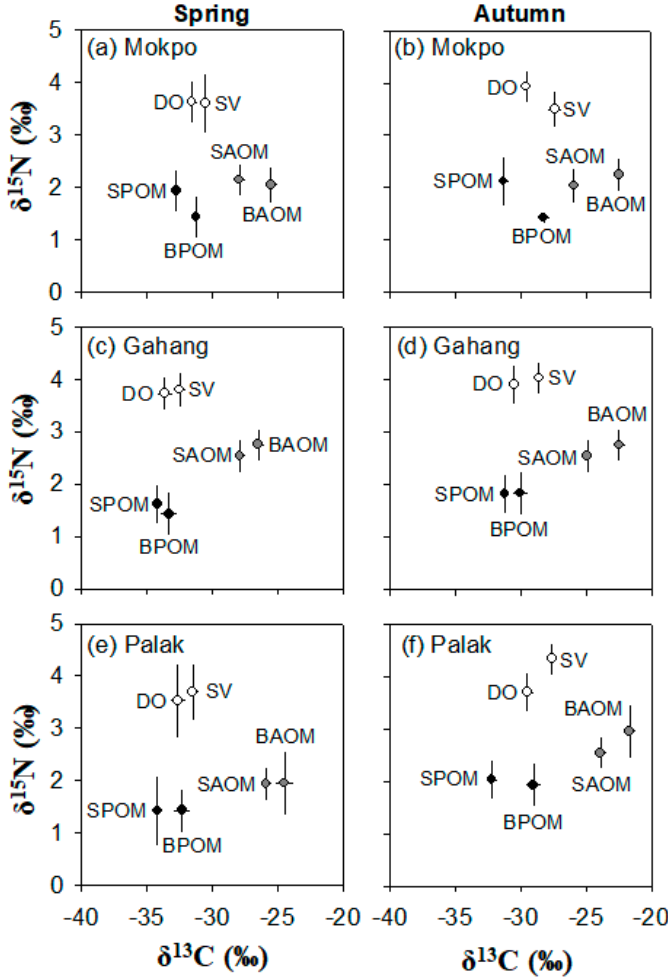
Figure 5. Carbon and nitrogen isotope plots at three wetlands from spring and autumn, 2011. Each symbol represents the mean signature of samples; error bars indicate ± 1 standard deviation (n = 4 or 5). Closed symbols are for the samples collected from the water surface, open symbols are for samples collected from the bottom. Surface particulate organic matter (SPOM); bottom particulate organic matter (BPOM); surface attached organic matter (SAOM); bottom attached organic matter (BAOM); Simocephalus vetulus (SV); Daphnia obtusa (DO).